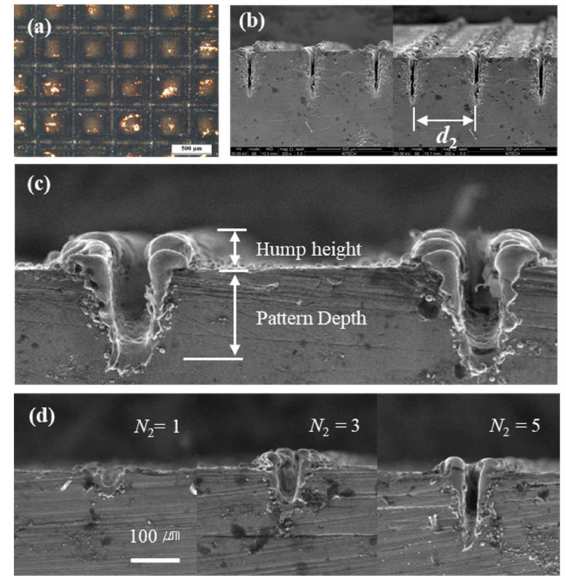
Figure 4. ( a ) The rectangular grid pattern of the laser patterning on the zinc-coated steel surface with d 2 = 500 µ m. ( b ) SEM image of the cross-section of the zinc-coated steel after rectangular patterning using nanosecond laser irradiation. ( c ) Magnified image of the cross-section of the zinc-coated steel after rectangular laser patterning. The hum height and the pattern depth are shown in the figure. ( d ) The SEM images of the zinc-coated steel after each laser